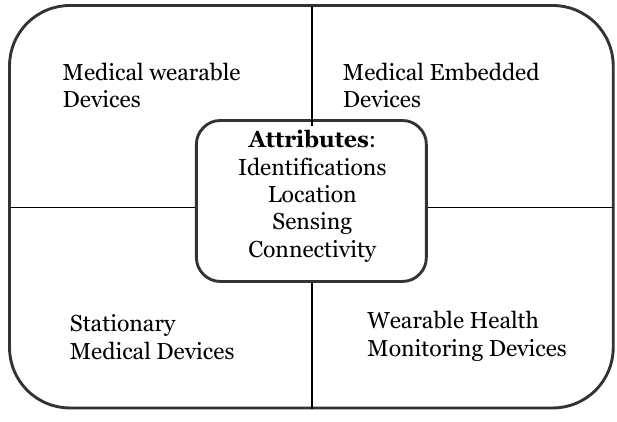
Figure 2. Healthcare IOT